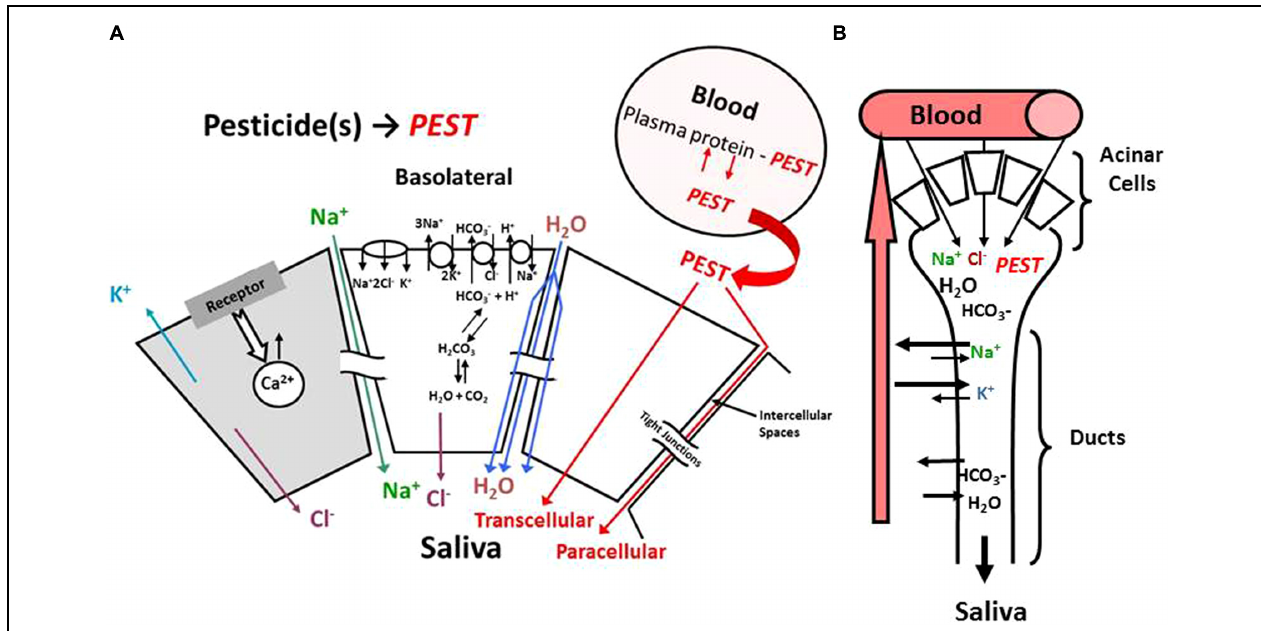
FIGURE 1 | Schematic model illustrating (A) acinar cell and (B) salivary duct function associated with saliva formation. PEST is used as a general notation for pesticides.